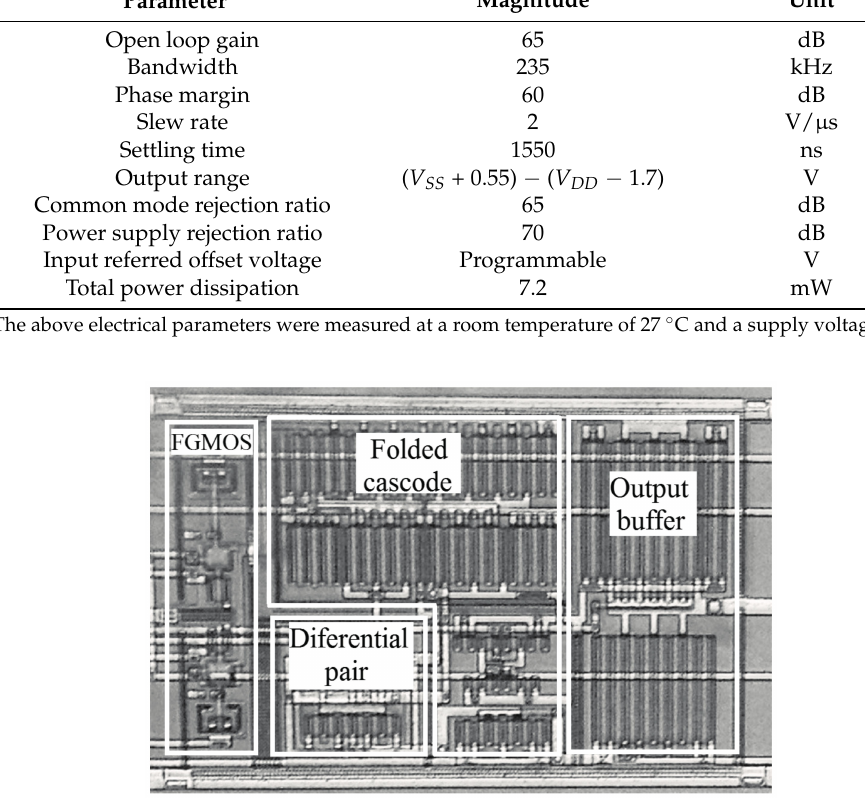
Figure 4. Microphotograph of the POOA. The final layout is 400 µ m × 245 µ m and requires about 15.6% more die area than a regular folded-cascode operational